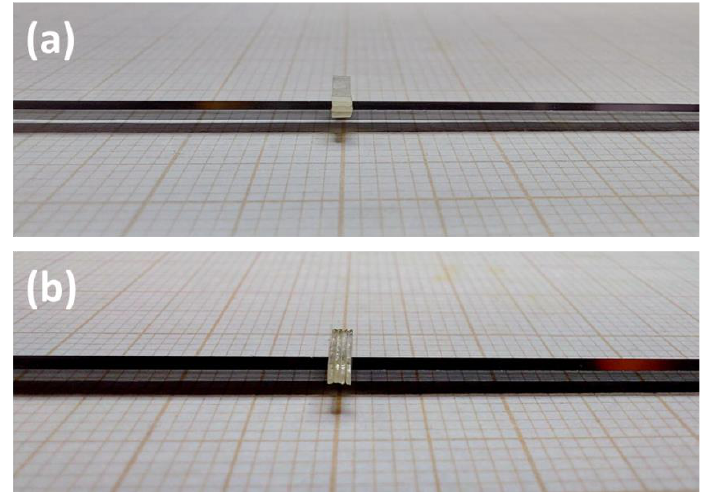
Figure A1. An example of the modification of a 5 × 5 mm 2 piece of 0.3 mm-thick sapphire sample into a symmetrical assembly of approximately 1.3 × 1.3 × 5 mm 3 . The sample is mounted onto a long Si stick serving as the final part of the QD MPMS typical sample holder for RSO measurements. ( a ) The sample is mounted for the in-plane measurements ( H is parallel to the surface of the original piece), and ( b ) the same sample is mounted for the perpendicular orientation.